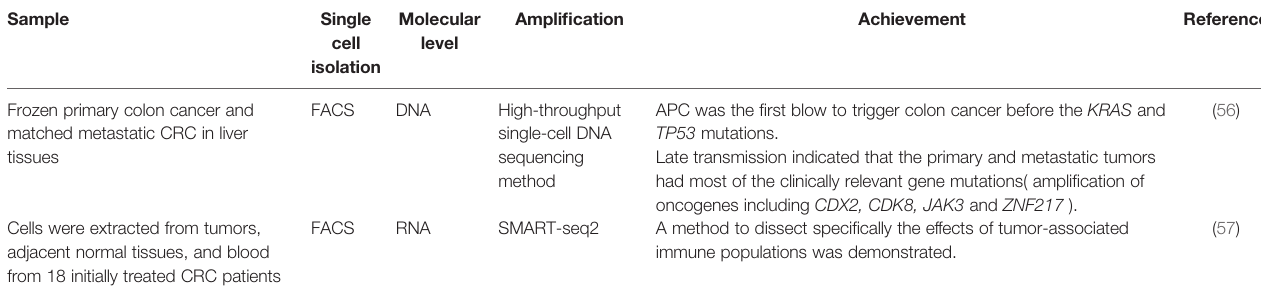
TABLE 9 | SCS in diagnosis and treatment of colorectal cancer.